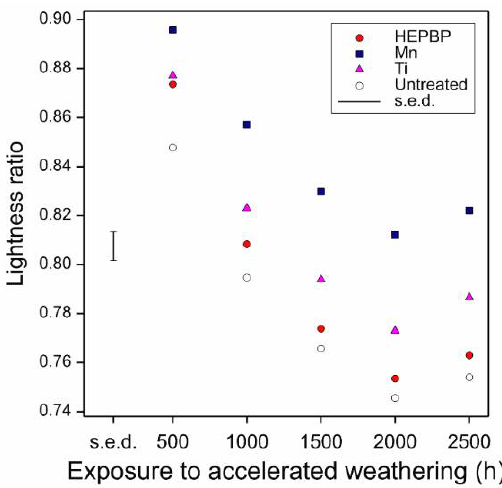
Figure 8. Darkening of pre-treated and untreated yellow cedar panels coated with a polyurethane coating and exposed to artificial accelerated weathering (four panels per treatment including the untreated control).